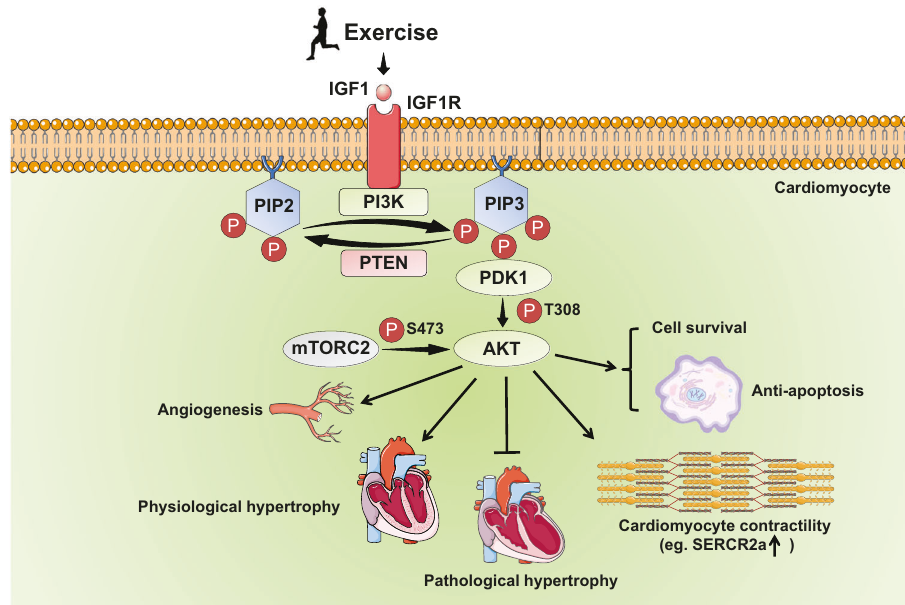
Fig. 2 The IGF1/PI3K/AKT pathway in exercise-induced physiological cardiac hypertrophy and exercise-induced cardioprotection. Exercise induces IGF1 secretion, which activates IGF1R tyrosine kinase followed by recruitment of PI3K. The PI3K through converting PIP2 to PIP3 in the plasma membrane, further leads to recruitment of PDK1 and AKT to the plasma membrane and subsequent phosphorylation and activation of PDK1 and AKT. The activation of IGF1/PI3K/AKT is essential to mediate exercise-induced physiological cardiac hypertrophy through promoting cardiomyocyte growth in size. The IGF1/PI3K/AKT pathway also exerts cardioprotective effects through promoting cardiomyocyte contractility, enhancing survival while reducing apoptosis of cardiomyocytes, inhibiting pathological hypertrophy, and promoting angiogenesis. IGF1 insulin growth factor 1, IGFR1 insulin growth factor 1 receptor, PI3K phosphoinositide-3 kinase, PIP2 phosphatidylinositol 4,5-bisphosphate, PIP3 phosphatidylinositol 3,4,5-trisphosphate, PDK1 phosphoinositide dependent kinase 1, AKT protein kinase B, PTEN phosphatase and tensin homolog, mTORC2 mammalian target of rapamycin complex 2, SERCA2a sarco/endoplasmic reticulum Ca 2 + -ATPase